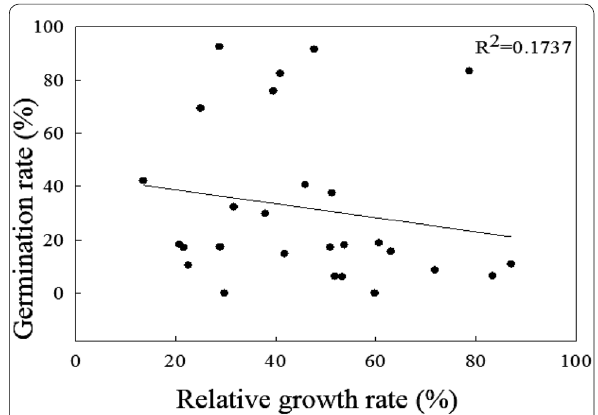
Fig. 5 Correlation between shoot RGR and relative germination rate under the TIR48 treatment. Dots in the figure indicate varieties tested in this study and there are 27 varieties